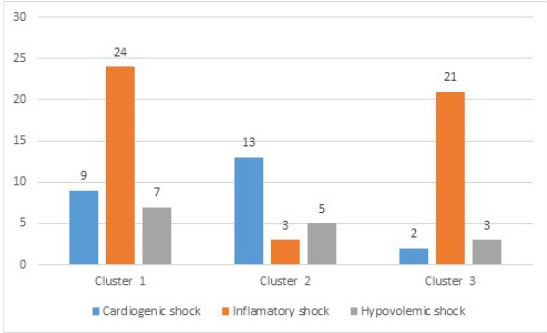
Figure 2. Number of patients with each type of shock in every